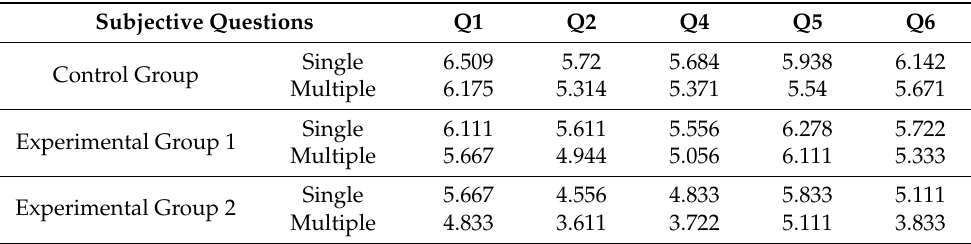
Table 8. The 7-point Likert scales-based scores of subjective questions in different conditions of all the